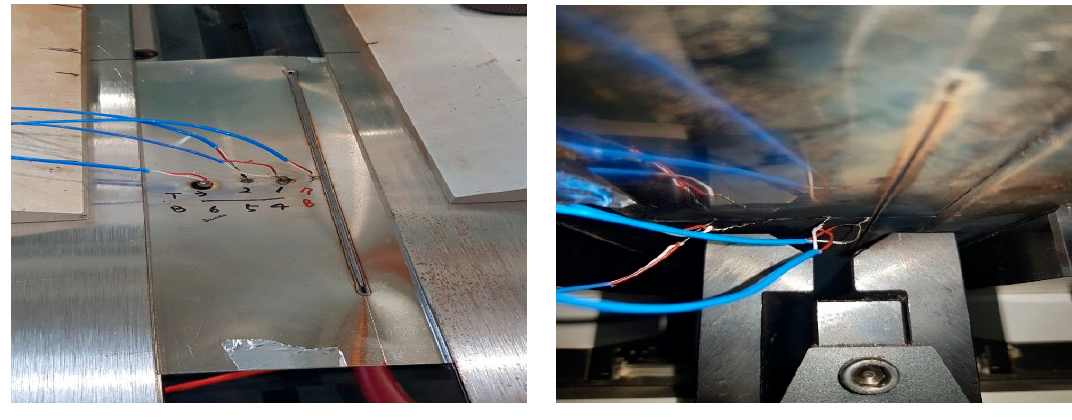
Figure 19. Thermocouple setting.